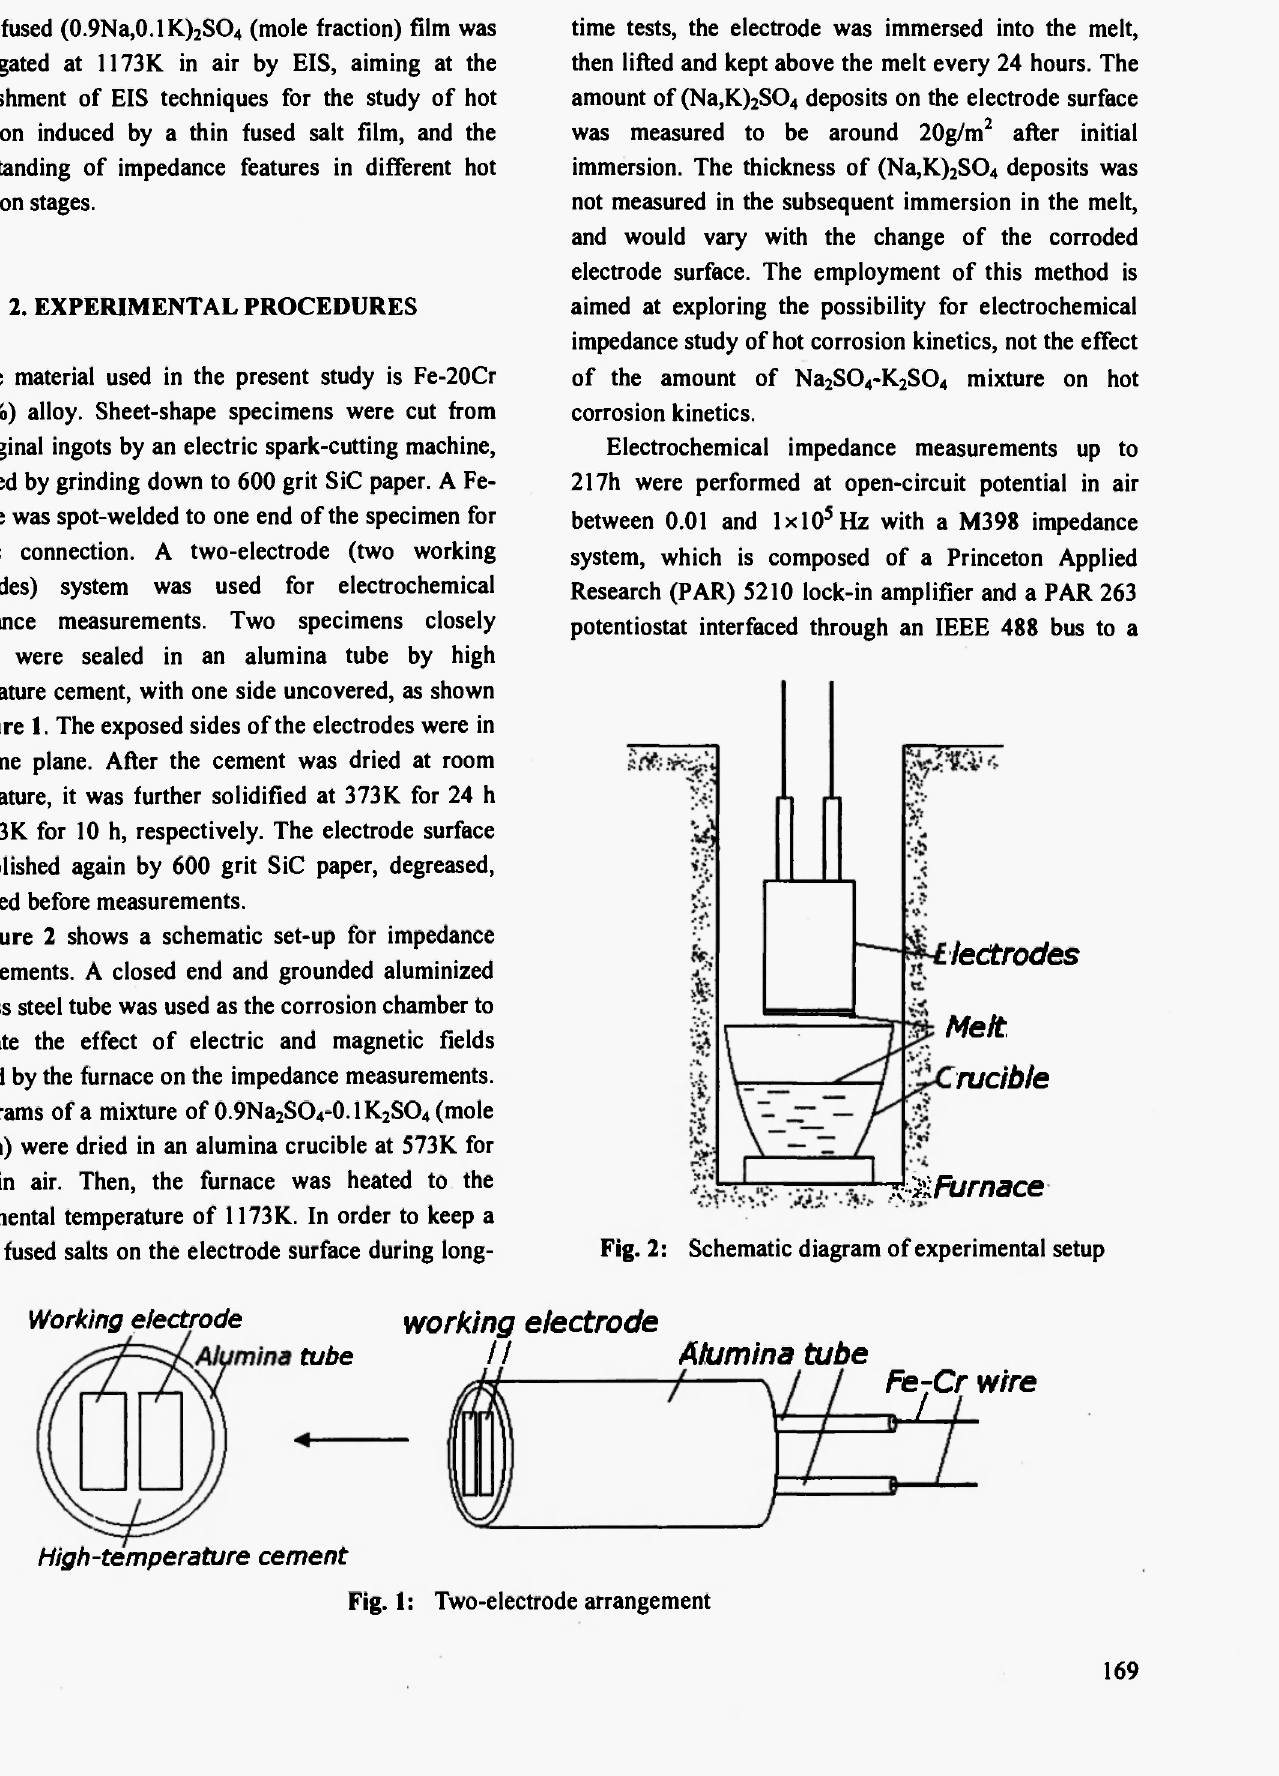
Fig. 2: Schematic diagram of experimental setup